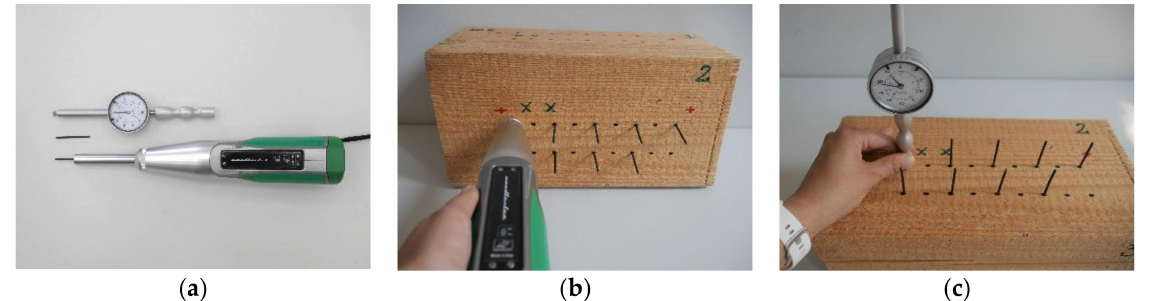
Figure 6. The device used for semi-destructive test (SDT) studies. ( a ) Woodtester Novatest and accessories; ( b ) Dynamic insertion of sclerometer pins; ( c ) Penetration depth readout.